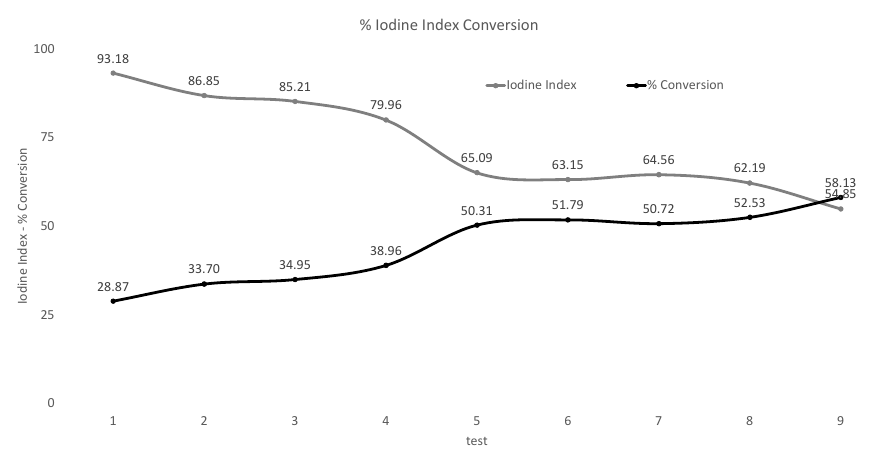
Figure 4. Iodine index